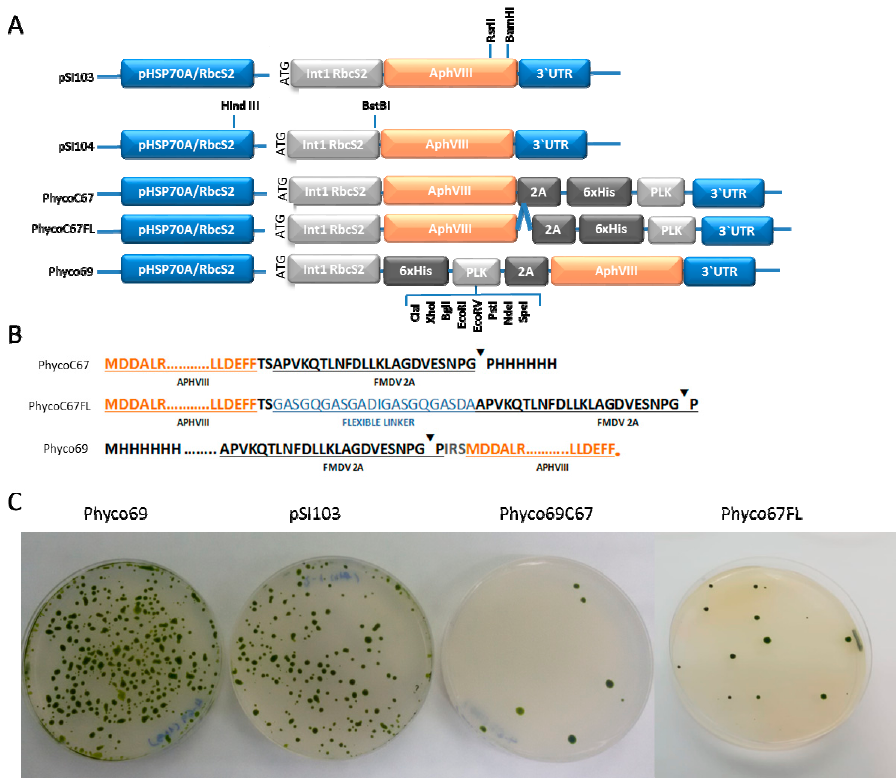
Figure 1. Schematic diagram of the main elements of the three new plasmids generated in this work in comparison with the control pSI103 plasmid ( A ) and of the translation products resulting from them ( B ). The blue line " " represents the flexible peptide sequence GASGQGASGADIGASGQGASDA. " " denotes the hydrolysis point in the self-cleaving peptide FMDV-2A. Representative examples of the nuclear transformation of Chlamydomonas reinhardtii with the three newly generated plasmids (Phyco69, PhycoC67, and PhycoC67FL) and the control pSI103 plasmid are also shown ( C ).